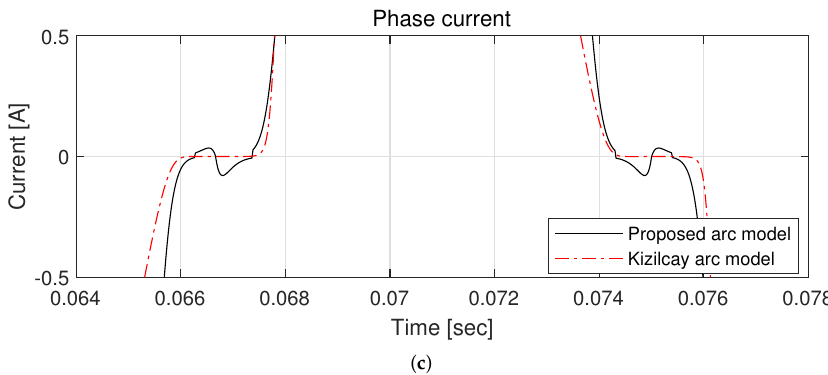
Figure 8. Phase voltage and phase current in simulations. ( a ) Phase voltage. ( b ) Phase current. ( c ) Phase current (zoomed in x- and